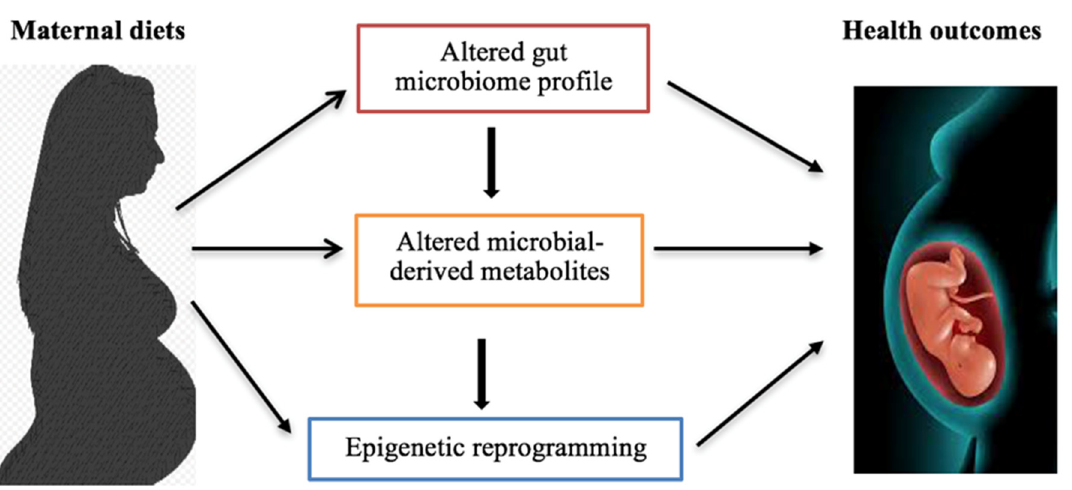
Figure 3. Maternal diets influence microbiome-metabolomics-epigenetics interplay, resulting in health outcome changes. Maternal diets can alter the gut microbial profile and microbiota-synthesized metabolites. Additionally, the transplacental transfer of maternal intestinal microbes and metabolites to the developing fetus can influence epigenetic reprogramming progresses in fetuses. Principally, this crosstalk influences offspring health outcomes, such as metabolic disease susceptibility, later in life.